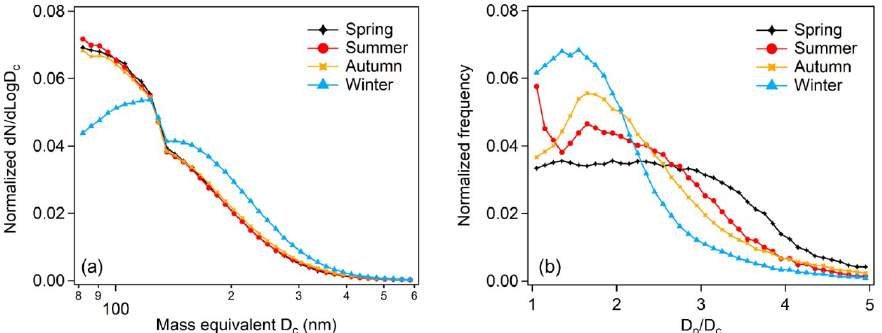
Figure 2. Normalized number size distributions of (a) the BC core ( D c ) and (b) D p /D c of BC-containing particles from SP2 measurement in the four seasons.